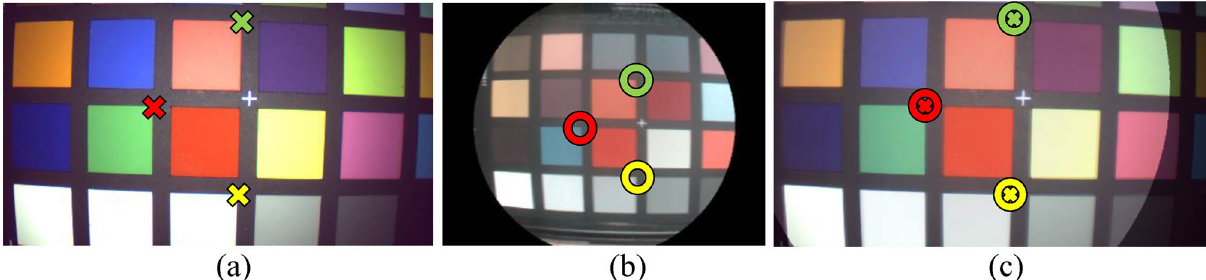
Figure 3. One-time registration of color video and hyperspectral data. ( a ) Image from the color sensor with three exemplary markers. ( b ) Pseudocolor image reconstructed during HSI of the same object. Missing information in the blue spectral range causes diverging coloration. Corresponding points to the markers in ( a ) are labeled with circles. ( c ) Semitransparent overlay of both images after perspective transformation based on 25 manually annotated